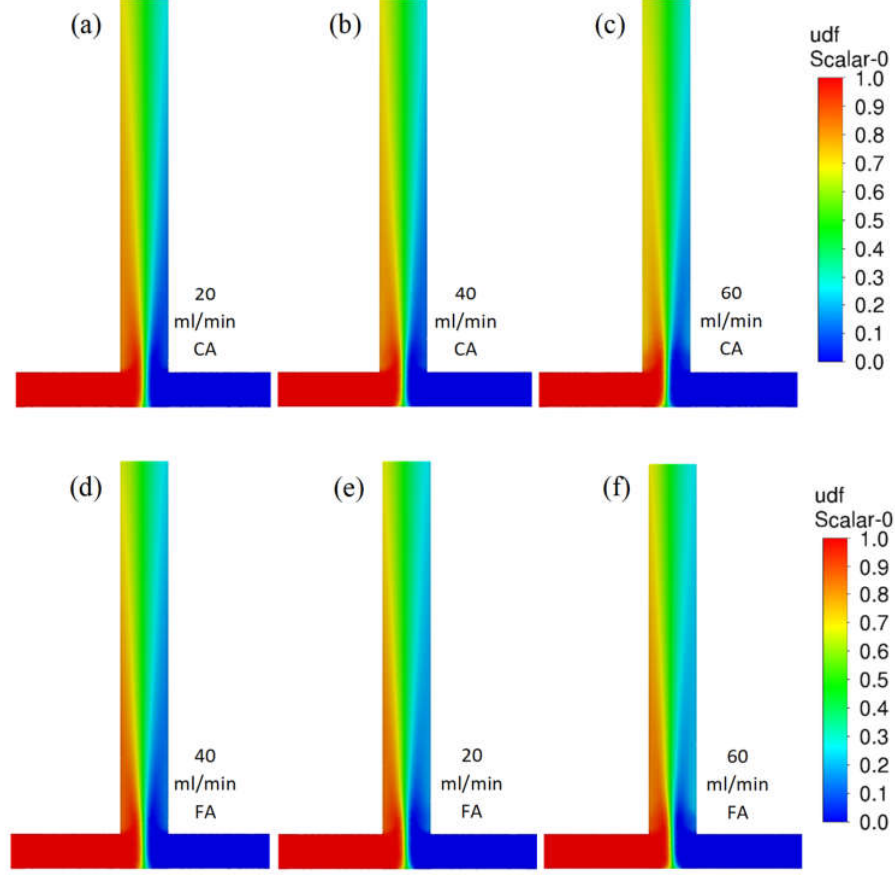
Figure 4. Contour profiles of dimensionless fraction of tracer in the T-reactor with citric acid (scale from 0 to 1) for various flow velocities ( a ) 20, ( b ) 40, and ( c ) 60 mL/min and for formic acid for flow velocities ( d ) 20, ( e ) 40, and ( f ) 60 mL/min.